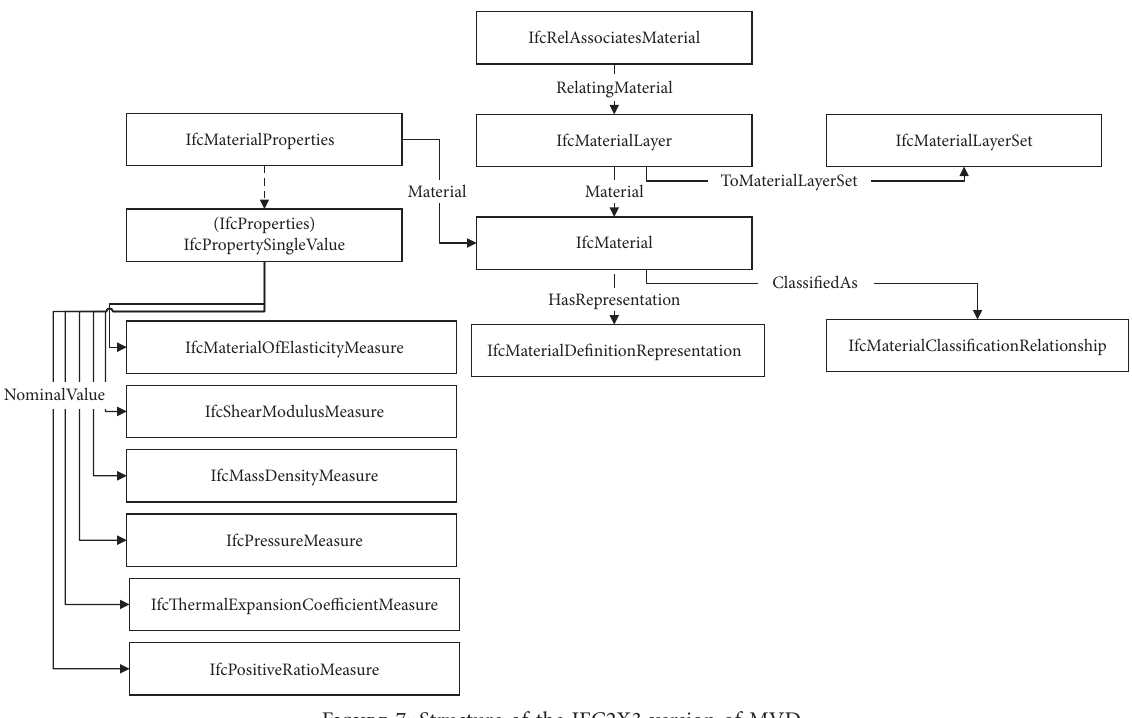
Figure 7: Structure of the IFC2X3 version of MVD.